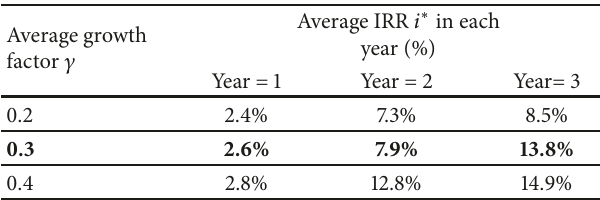
Table 6: Average IRR of the rail transit line project with respect to different growth factor of the total population over years.